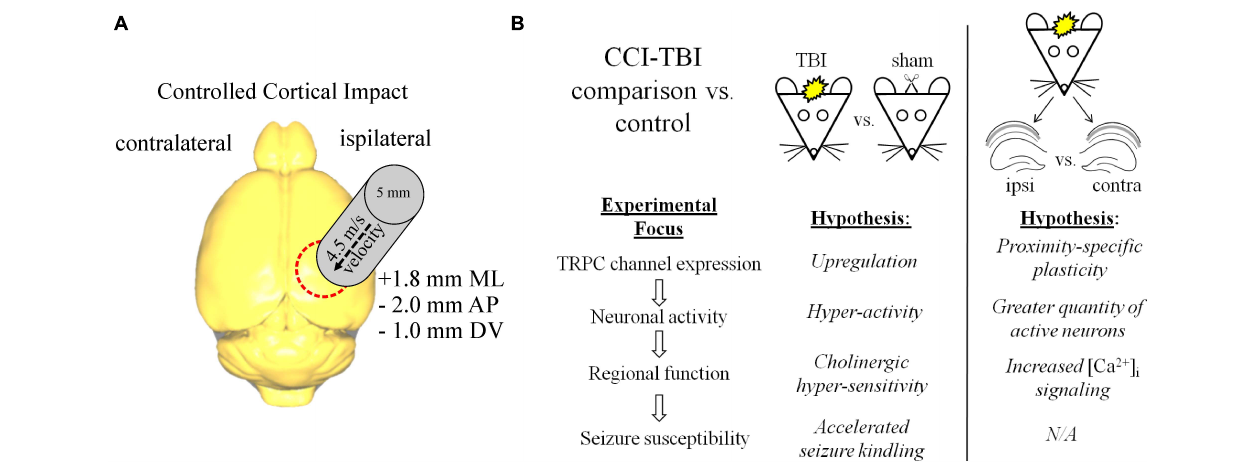
FIGURE 1 | CCI-TBI diagram and analytical schema for comparative expression of TRPC channels. (A) Depicted is a dorsal view of the mouse brain and the area of impact of CCI-TBI over the ipsilateral cortex. Detailed approach can be found in “Materials and Methods” section. (B) Outlined are the design approaches and hypotheses for this study in the comparison of control vs. TBI and ipsilateral TBI vs. contralateral TBI investigations.